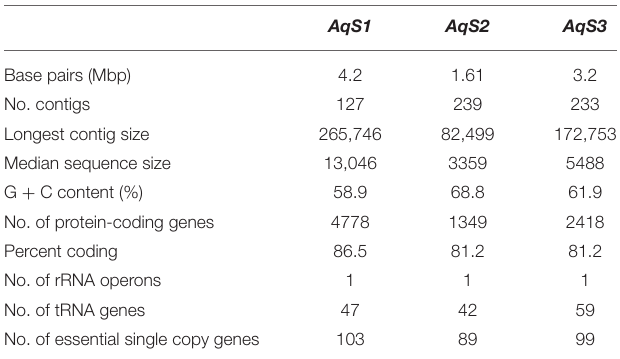
TABLE 1 | Summary of genomic features for the three main symbionts present in Amphimedon queenslandica